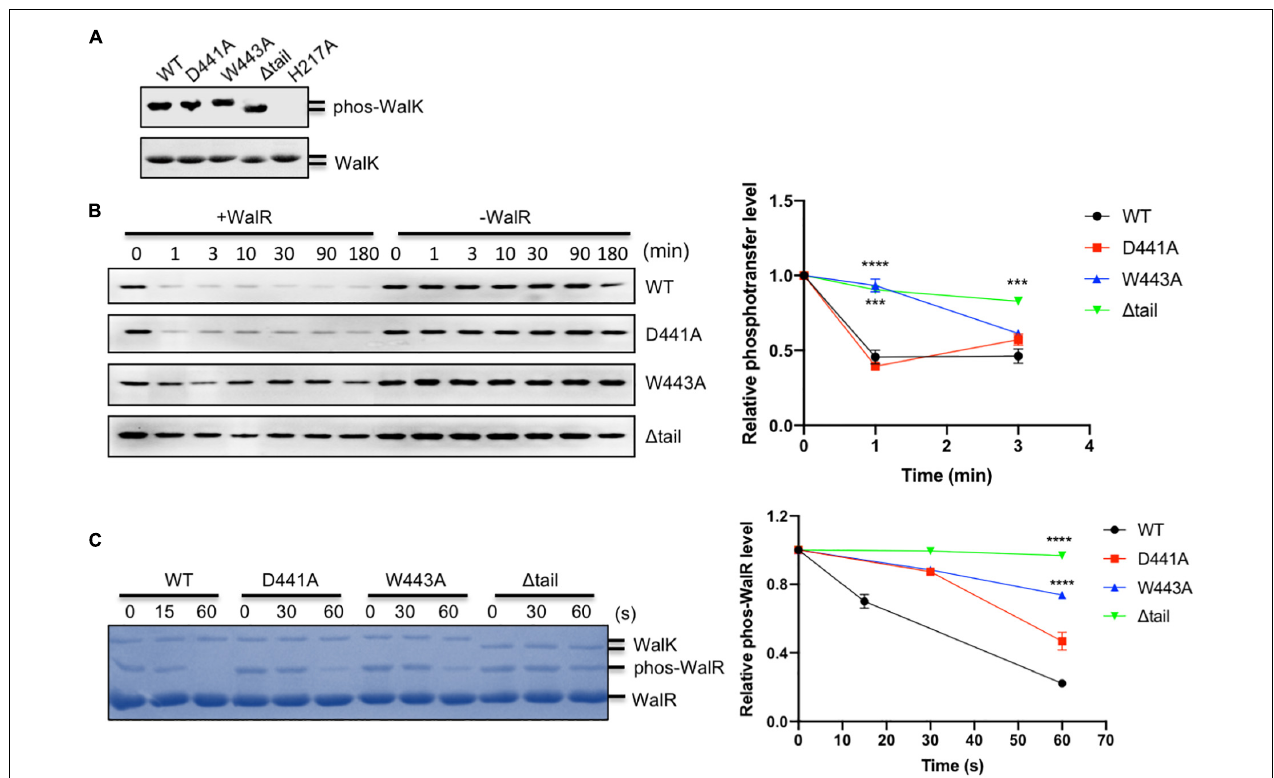
FIGURE 2 | The CTT of S. mutans WalK is indispensable for its enzymatic activities. (A) Autokinase activity of WalK (31–450) and its tail mutants. The WalK loadings were shown in the lower gel stained by CBB, while the phosphorylation of WalK was detected by ATP γ S and anti-thiophosphate antibodies shown in the upper gel. H217A is an autokinase inactive mutant. (B) Phosphotransferase of WalK. The phosphotransferase activity was examined by the reduced phosphorylation of WalK incubated with WalR and detected using ATP γ S and anti-thiophosphate antibody over time. Quantitative analysis of phosphotransferase activity normalized to 0 min is shown below the gel. (C) Phosphatase of WalK. Phosphorylated WalR was incubated with WalK and its derivatives at 1:5 (WalK:WalR), separated from the dephosphorylated WalR in a Phos-tag gel and stained with CBB. Quantitative analysis of phosphatase activity is below the gel. The phosphorylated/dephosphorylated WalR was estimated, normalized to its initial amount at 0 s of the gel. Data presented are means ± standard deviations (error bars) for three independent experiments. Student’s t -tests were used to compare mutants to WT at each time point (*** p < 0.001 and **** p <